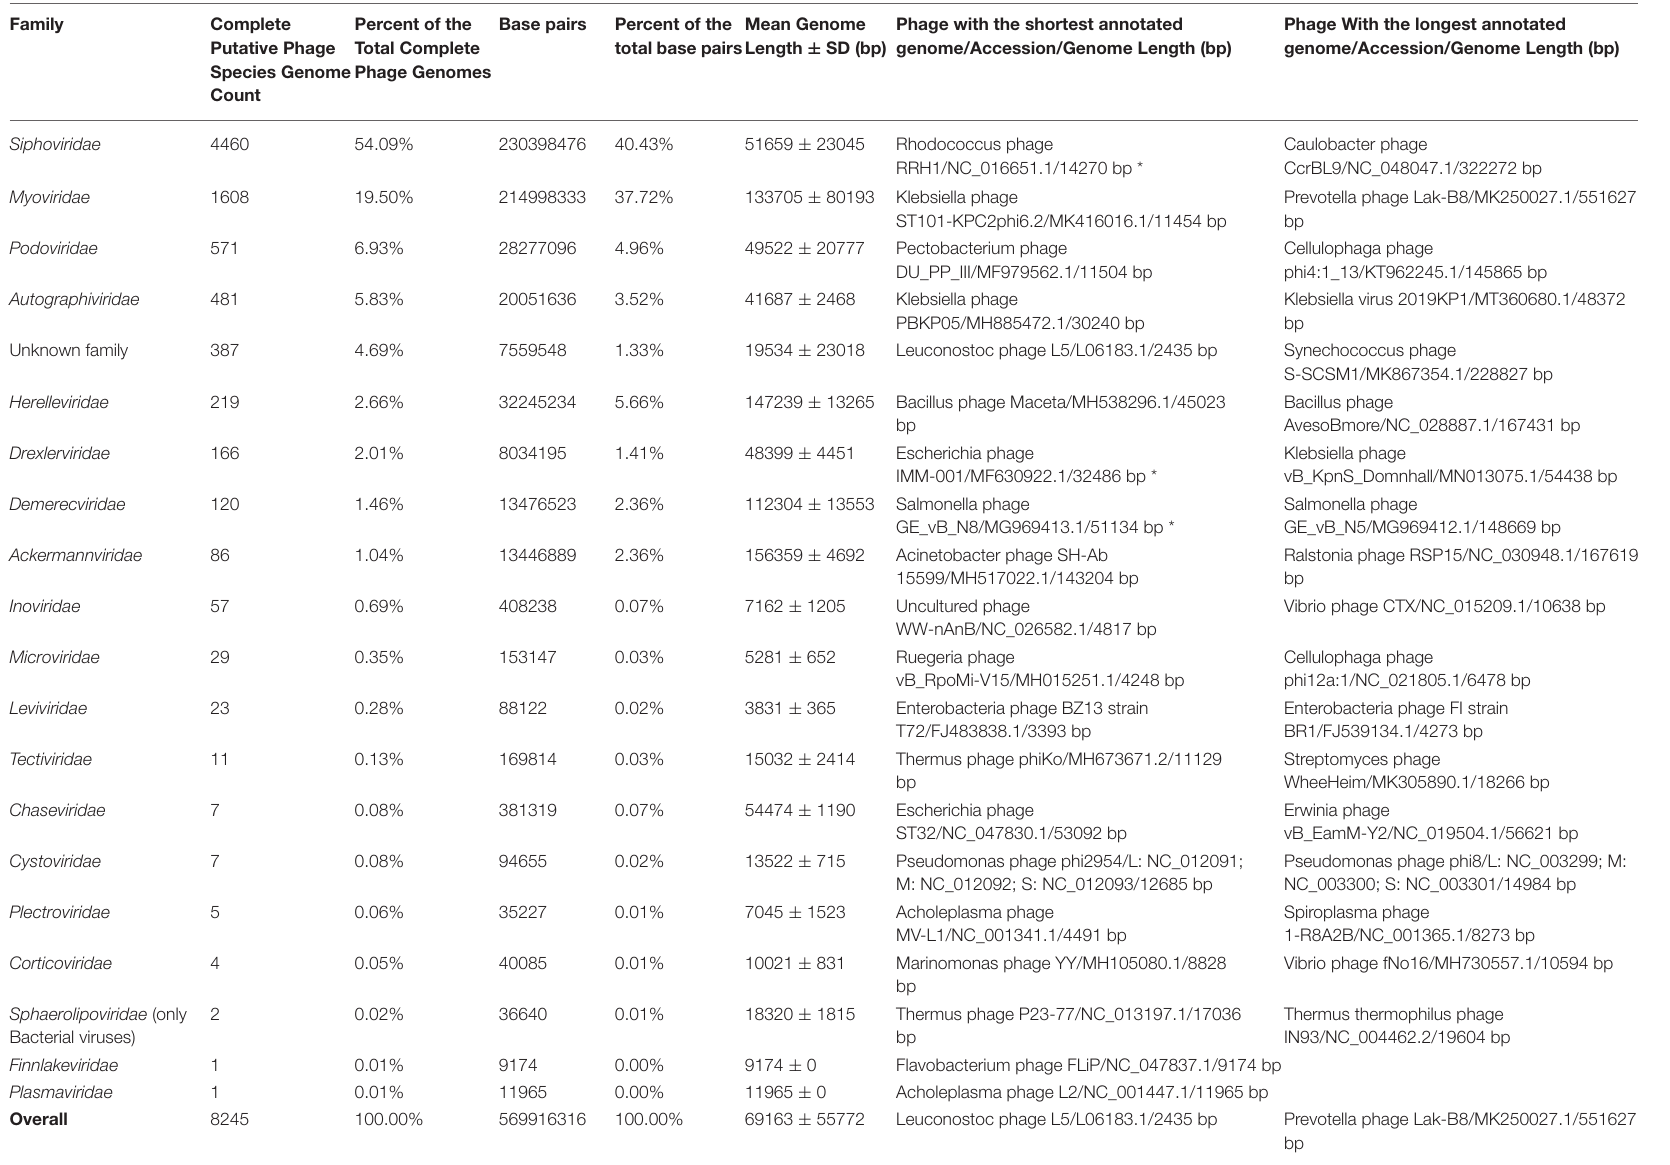
Asterisk near entry in the column representing the shortest genome of a phage of a given family indicates the shortest plausible entry and ignores ambiguous entries labeled as “complete